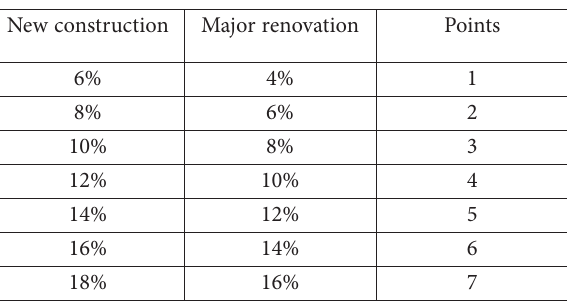
Table 2. LEED grading and scoring of the percentage of optimized energy performance (LEED: Optimize energy performance,